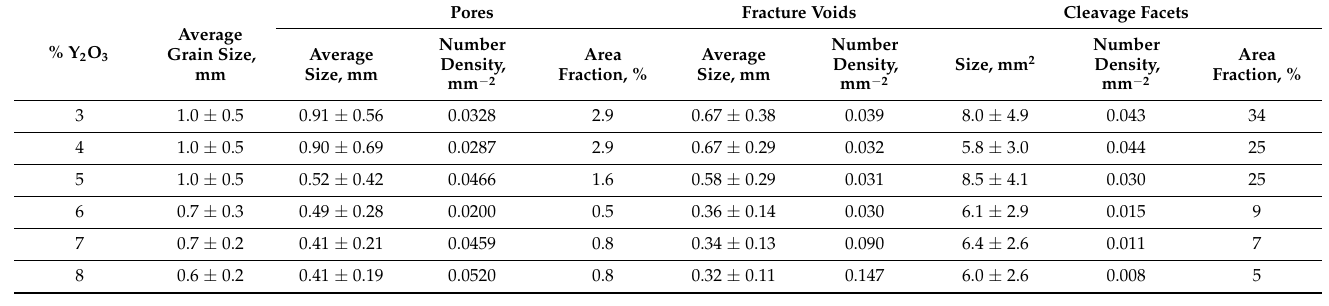
Figure 1. Optical images of non-etched microstructure in the studied materials containing ( a ) 3%,